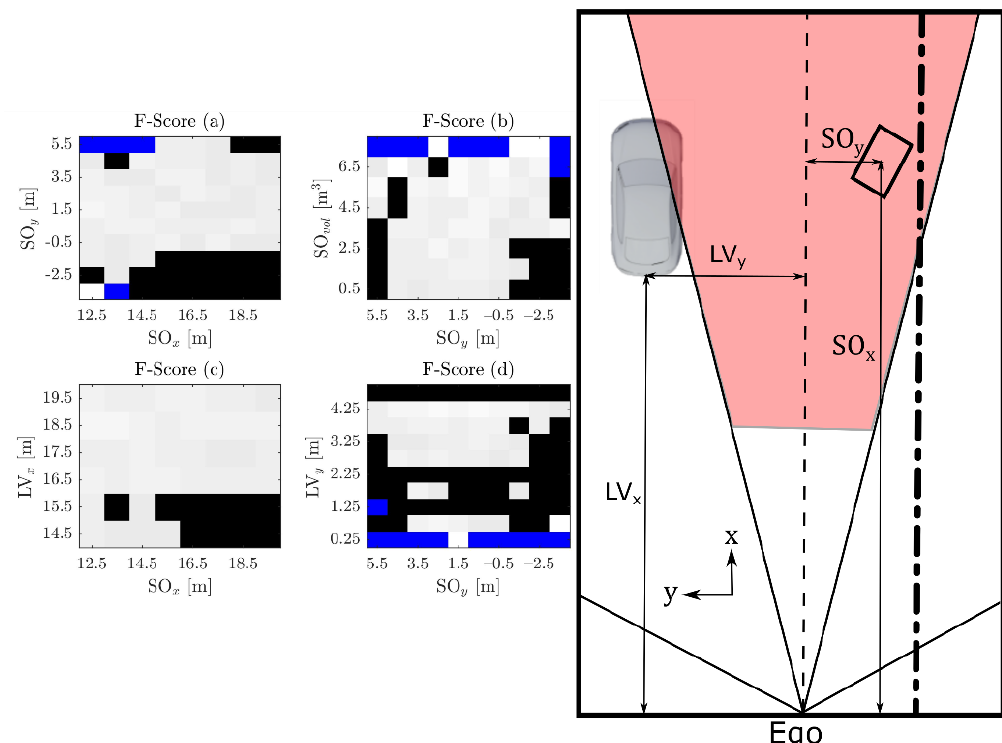
Figure 9. Classification results are analyzed in detail by dividing the available data into small portions. Regions where the F-Score is lower than 92% are shown in black. Blue regions are empty (the combination of parameters currently does not contain any example). On the right, the meaning of each of the parameters is shown. SO vol corresponds to the volume of the synthetic object, SO x and SO y to its coordinates. LV x and LV y correspond to the coordinates of the leading vehicle. In both cases, the position is calculated with respect to the position of the LIDAR sensor on the Ego vehicle. The difficulty of the classification task increases when the synthetic object is located close to the road boundary ( a , b ) or when is close to the LV and has a small size ( b ), additionally when the synthetic object is farther away in x-direction as the LV ( c ) or when the LV moves to the Ego lane ( d).